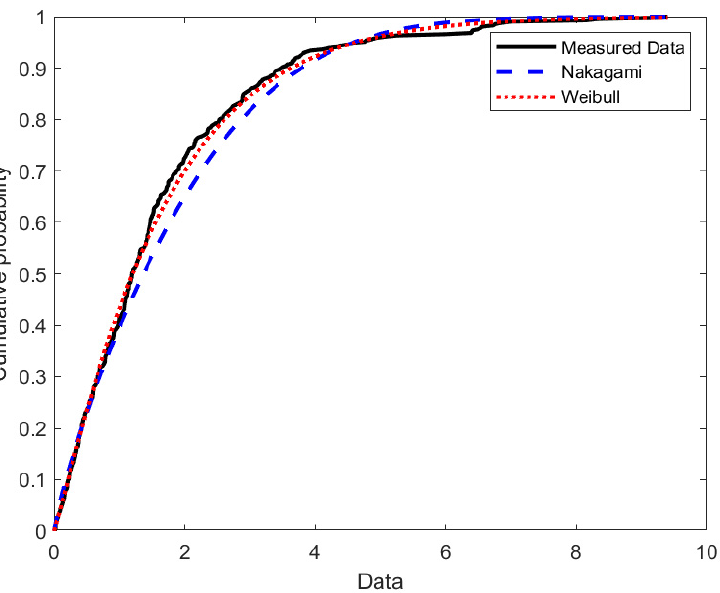
Figure 10. Cumulative distribution functions fitting fast variations within the auditorium at 3.5 GHz in LoS conditions.